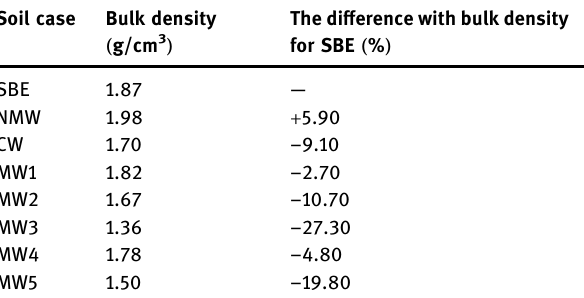
Table 5: The percentage of increase and decrease in the amount of porosity of the soil Soil case